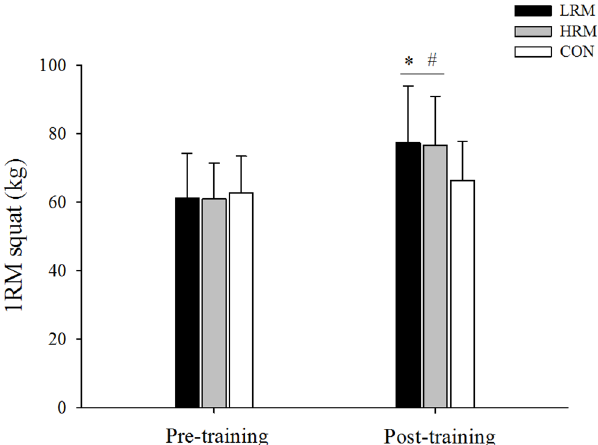
Fig 2. Mean ± SD of squat maximal strength pre and post 9 week of resistance training. LRM, heavy load – low repetition maximum resistance training group. HRM, moderate load – high repetition maximum resistance training group. CON, control group. ( * ) p < 0.05, higher than pre training. (#) p < 0.05, higher than CON